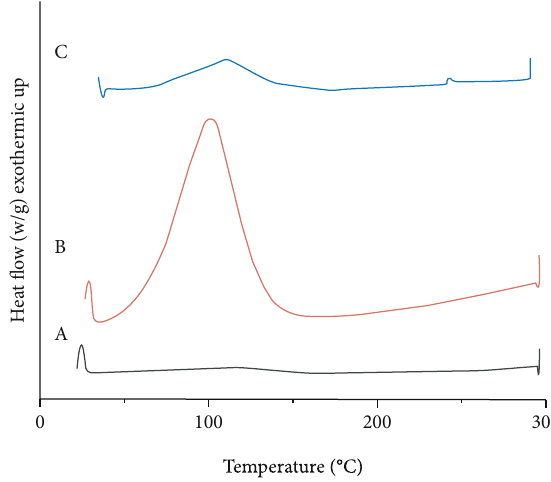
Figure 7: DSC curves of (a) neat SAN, (b) mixture of epoxy resin and amine in the nonencapsulated form, and (c) mixture of crushed epoxy resin and amine contained MCs. Table 2: The determined results of core content and encapsulation